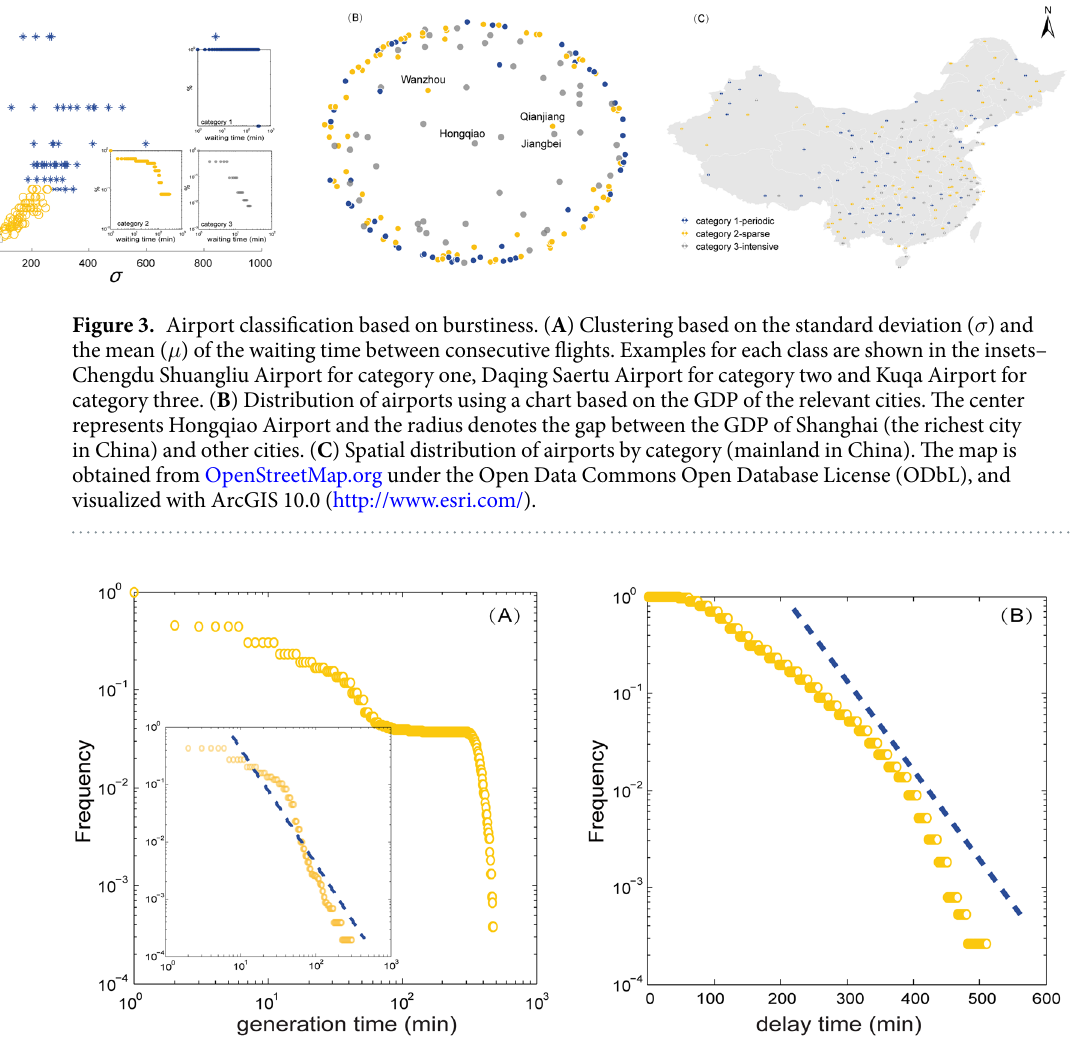
Figure 4. Distribution of generation time on nodes and delay time on edges within CAN. ( A ) Distribution of generation time on nodes. The distribution after 6:00 is shown in the inset. ( B ) Distribution of delay time on